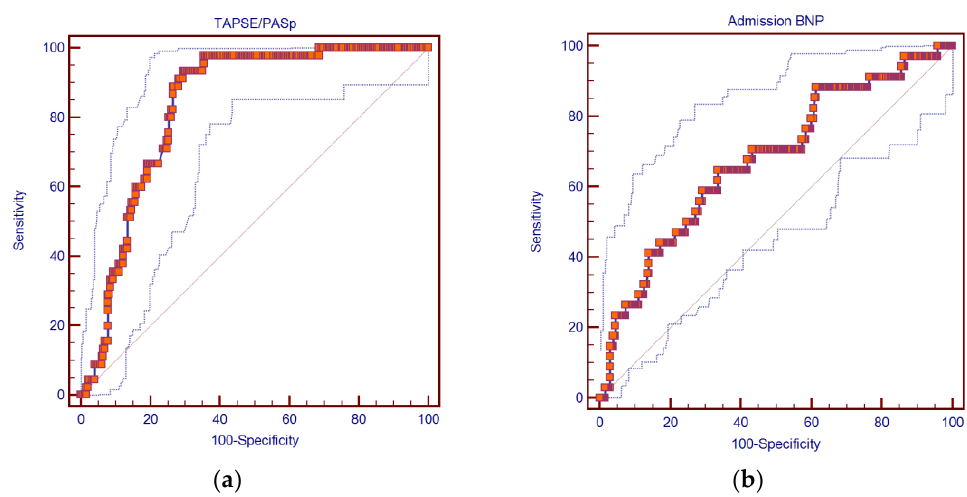
Figure 2. ROC curves of: ( a ) TAPSE/PASp, considered as a continuous variable (AUC: 0.831; 95%CI: 0.782 – 0.872; p < 0.0001); ( b ) admission BNP, considered as a continuous variable (AUC: 0.667;